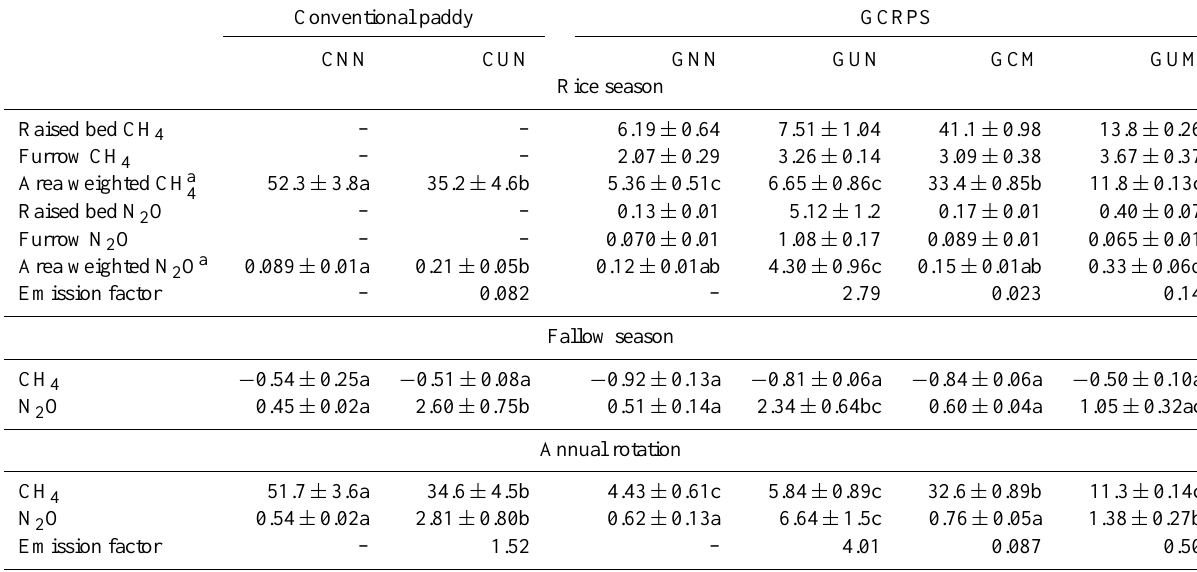
a The area weighted emissions of CH 4 and N 2 O for the GCRPS treatments in the rice season were calculated on the basis of the areal extent of furrow and raised bed. Data shown are means ± standard errors of three spatial replicates. Definitions of abbreviations for the different fertilizer treatments are shown in the footnotes of Table 1 and in the text. Different letters within the same row indicate statistically significant differences among treatments.